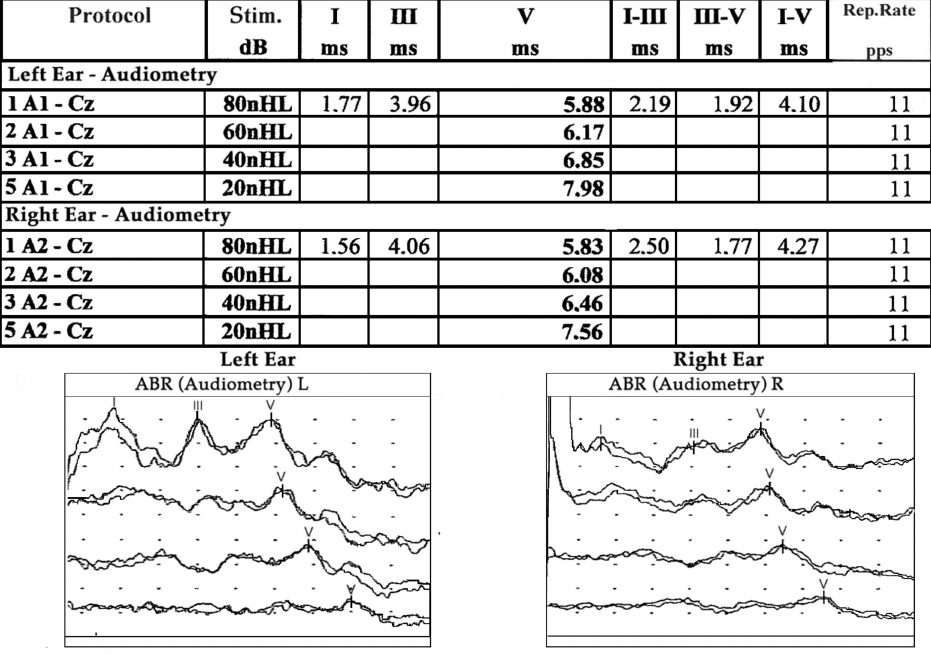
Figure 3. Auditory brainstem responses at 9 months of age by monoaural click with contralateral masking of +30dB. Hearing tresholds within normality. Stim.: Stimulation; Rep.Rate: repetition rate; ms: milliseconds; Cz: reference electrode in the vertex; A1: registration electrode; HL: normalized hearing level; ABR: Auditory brainstem